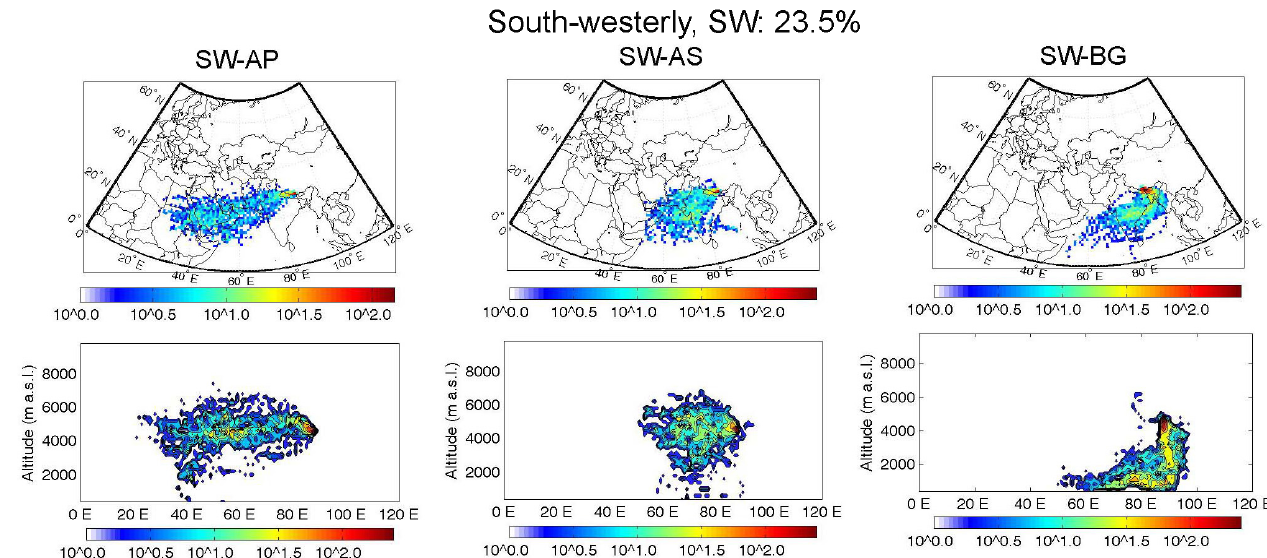
Fig. 5b. As in Fig. 5a but for south-westerly “SW” clusters.